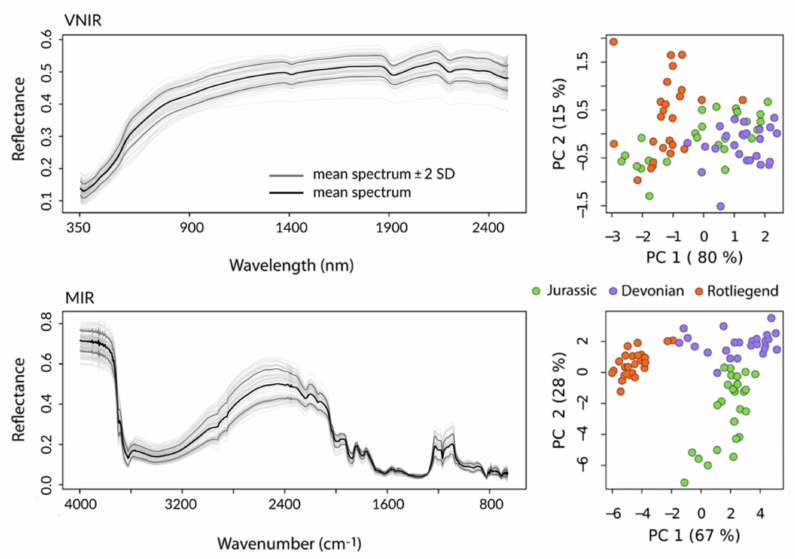
Figure 3. VNIR and MIR spectra of the collected soil samples ( n = 75) in light gray showing the total spectral variation across the sampled soil data; the mean spectrum (black) and its associated ± 2 standard deviation (SD) envelope (dark gray) illustrate prominent absorption features in the spectra. Right-hand panel shows the corresponding location of the spectra in the principal component feature space, color-coded by underlying geologic